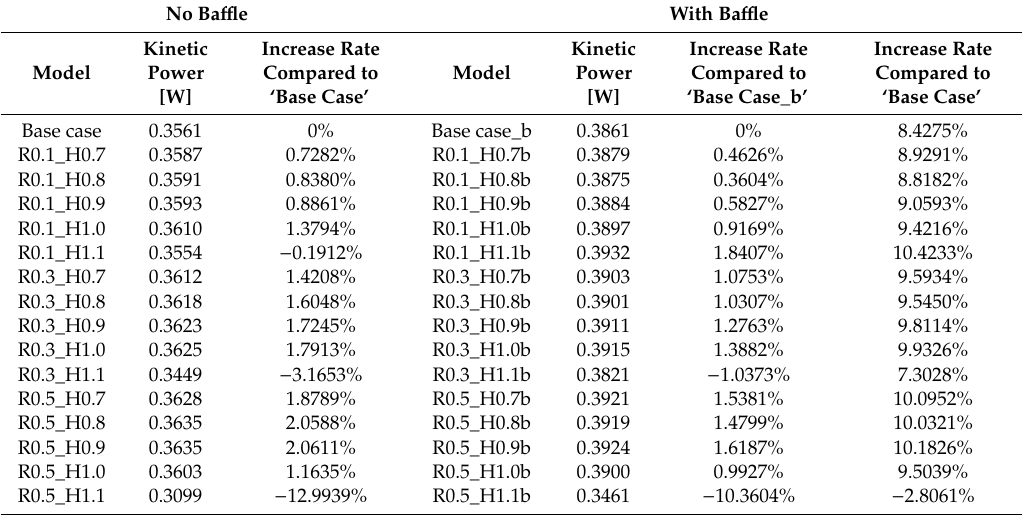
Table 2. Kinetic power calculated from the numerical analysis models and the relative increase compared to the base